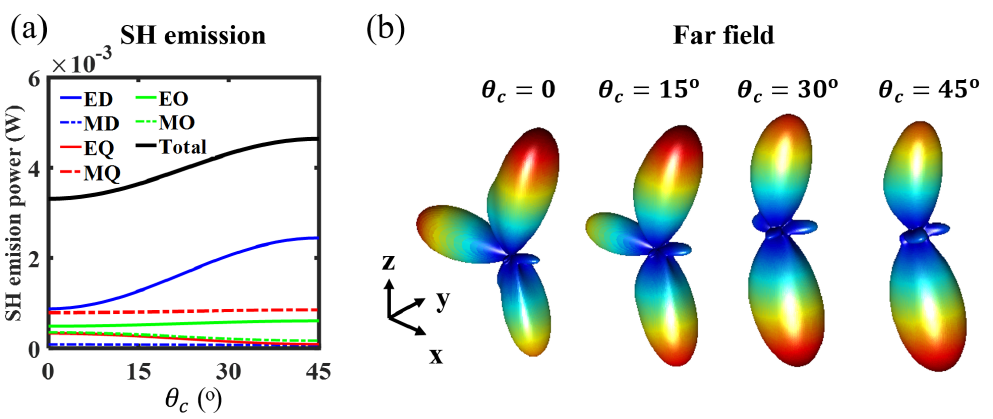
Figure 8. ( a ) Calculated SH emission power and the nonlinear multipolar structure as a function of θ c ; ( b ) the far-field patterns for different rotating angles θ c